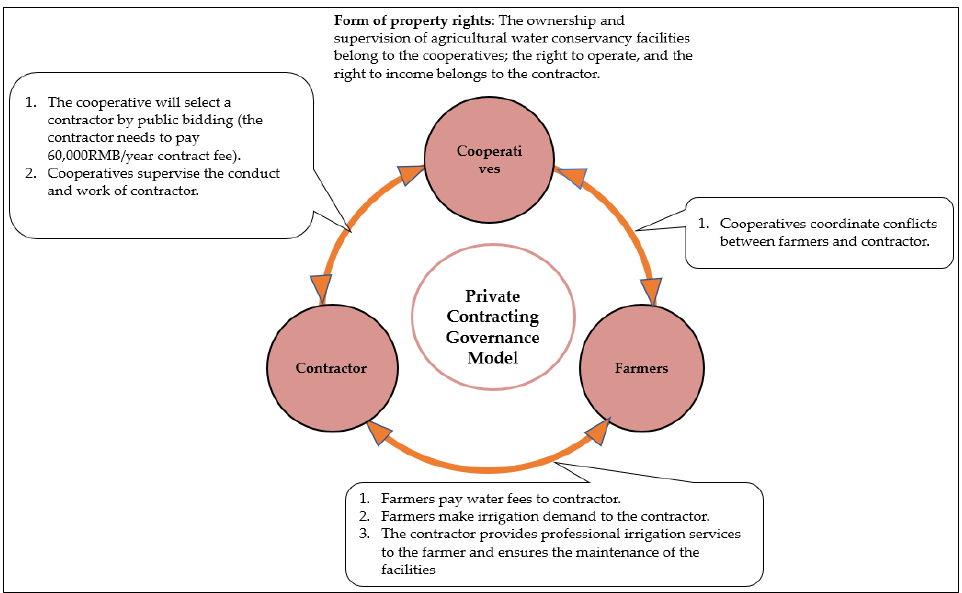
Figure 2. Governance logic diagram of the “ Private contracting governance model ” .